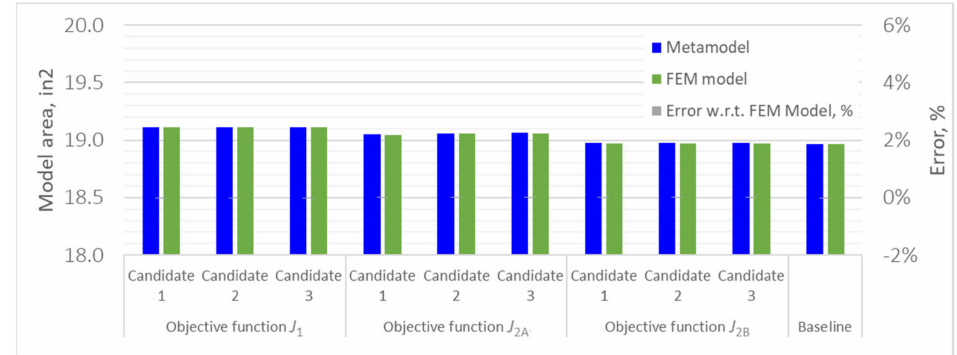
Figure 21. Metamodel validation with FEM model results.